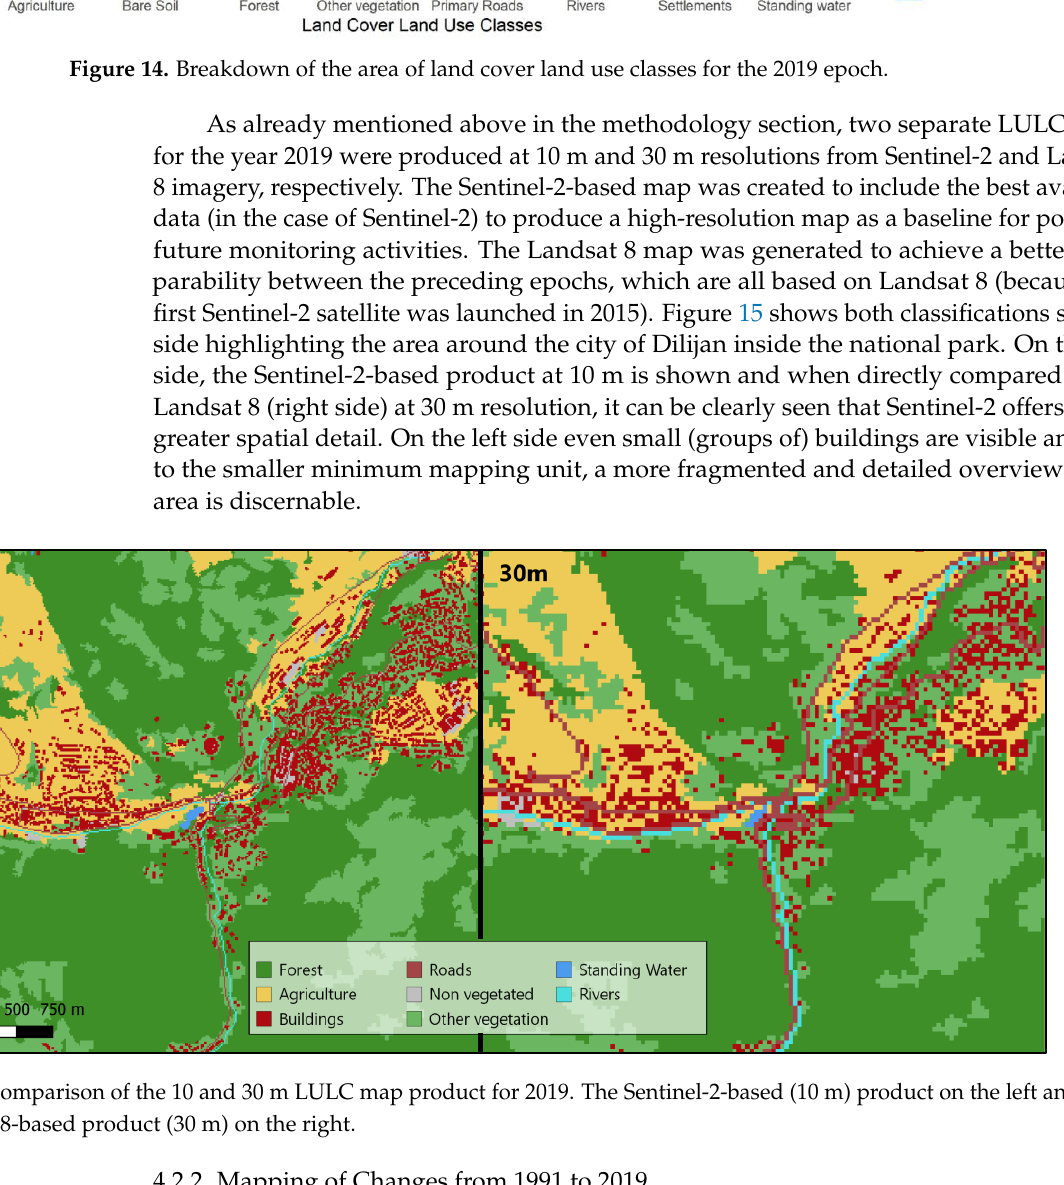
and the Landsat 8-based product (30 m) on the right. the Landsat 8-based product (30 m) on the